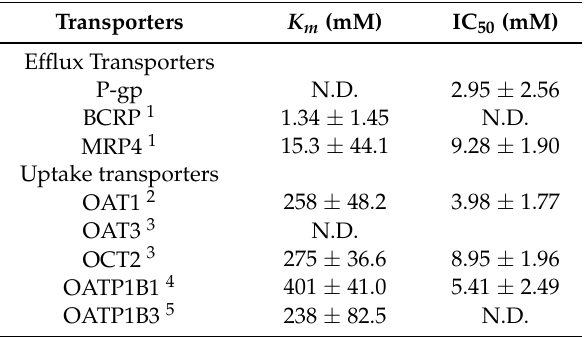
Figure 4. ( a – c ): The concentration dependency of [ 14 C]fluciclovine in ( a ) P-glycoprotein (P-gp)-; ( b ) breast cancer resistance protein (BCRP)-; and ( c ) multidrug resistance-associated protein 4 (MRP4)-expressing inside-out vesicles; ( d – f ): the inhibition of tracer uptake by unlabeled fluciclovine in ( d ) P-gp-; ( e ) BCRP-; and ( f ) MRP4-expressing inside-out vesicles. Each data point represents the mean ± SD ( n = 3–6). “ES” and “E2G” indicate “[ 3 H]estrone-3-sulfate” and “[ 3 H]estradiol-17 β - D - glucuronide”, respectively. Table 1. K m and IC 50 values of fluciclovine for specific drug transporters.